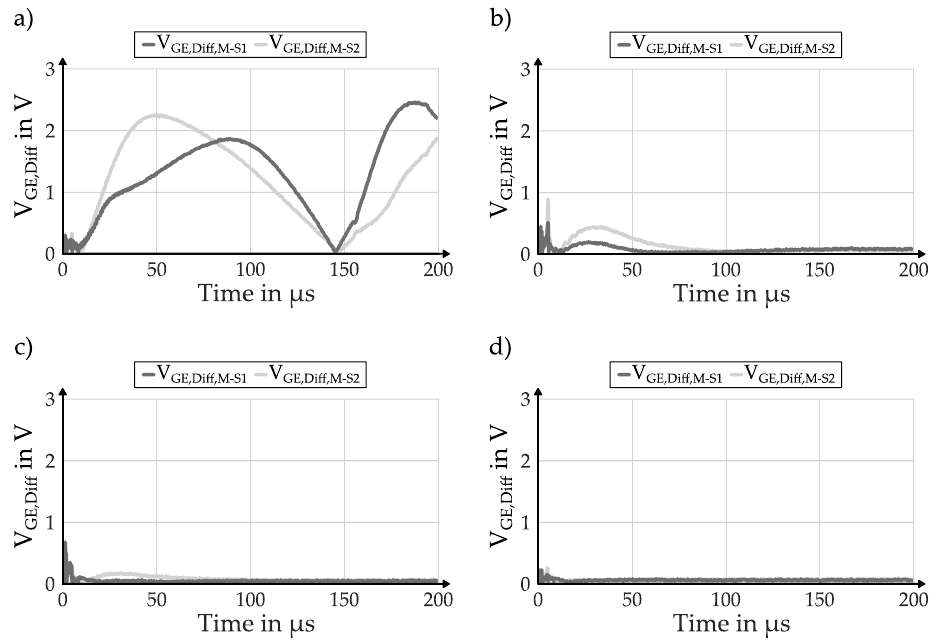
Figure 15. Experimental results of the absolute deviation of the slave PEBC modules’ from the master PEBC modules’ gate-emitter voltage V GE during switch-on operation of IGBTs for the investigated interconnection designs ( a – d ) as presented in Figure 12.